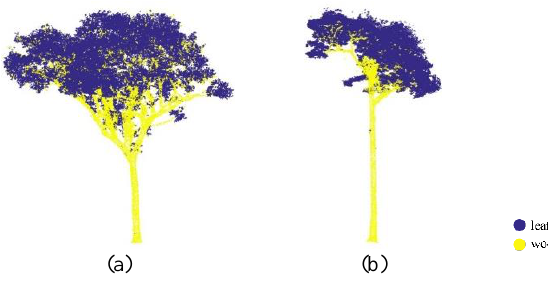
Figure 6. Two isolated tree point clouds with labeling information. Blue point represents leaf, while yellow point represents wood. (a) Tree 1 used for training; (b) Tree 2 used for testing.